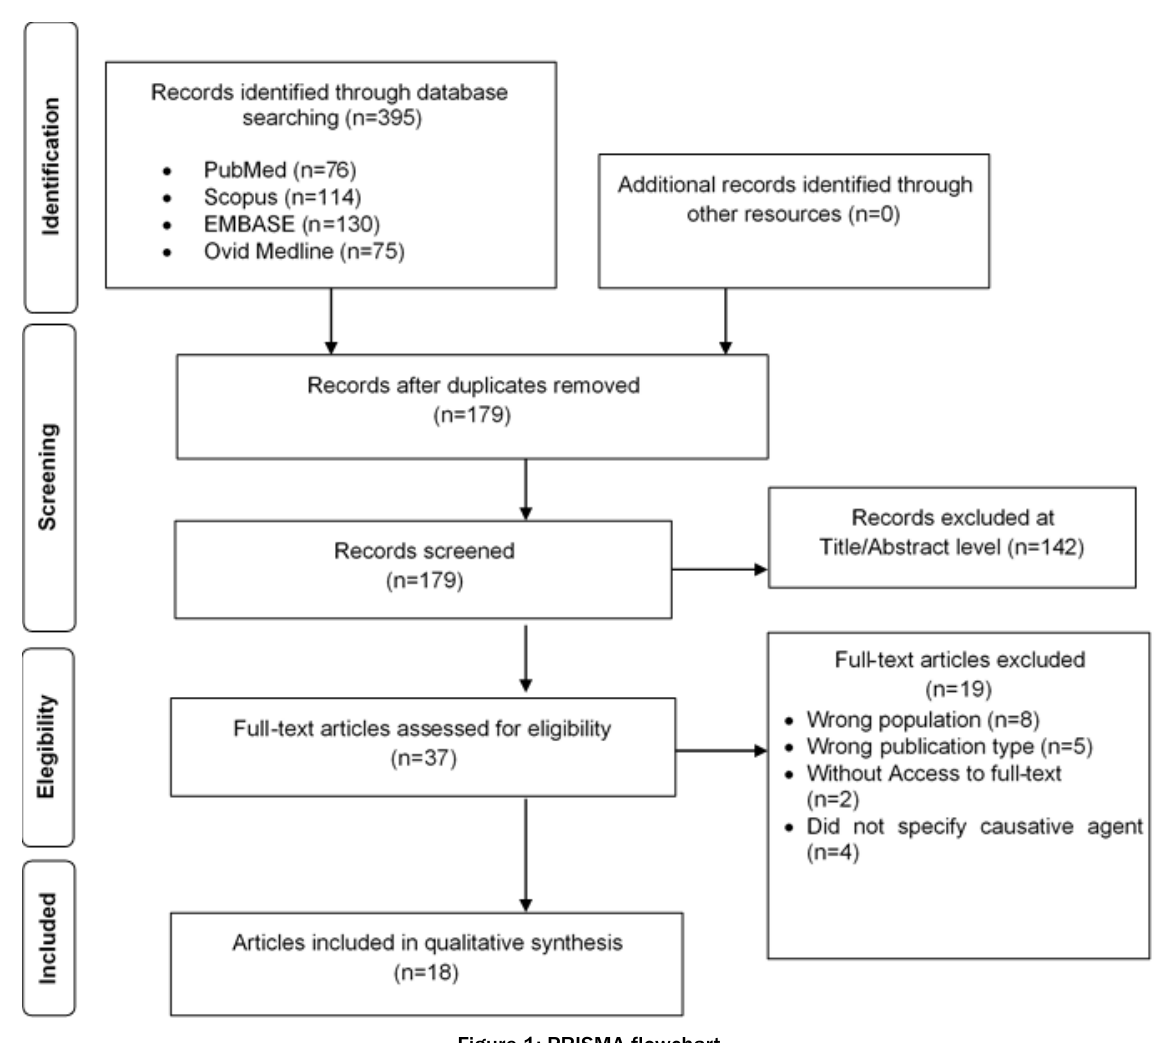
Figure 1: PRISMA